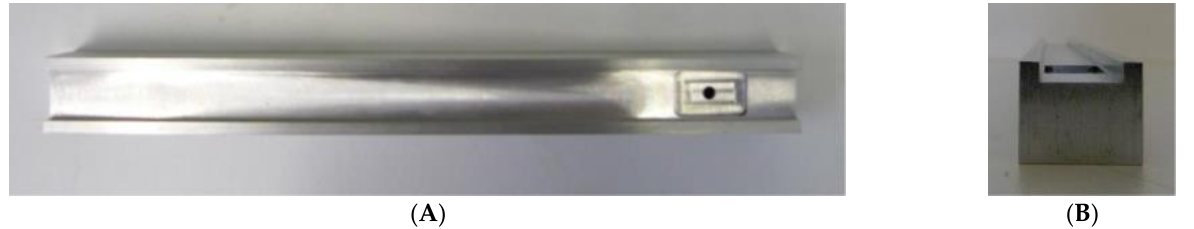
Figure 3. The interchangeable flow channel with a height of 5 mm: ( A ) top view of the flow channel and ( B ) side view of